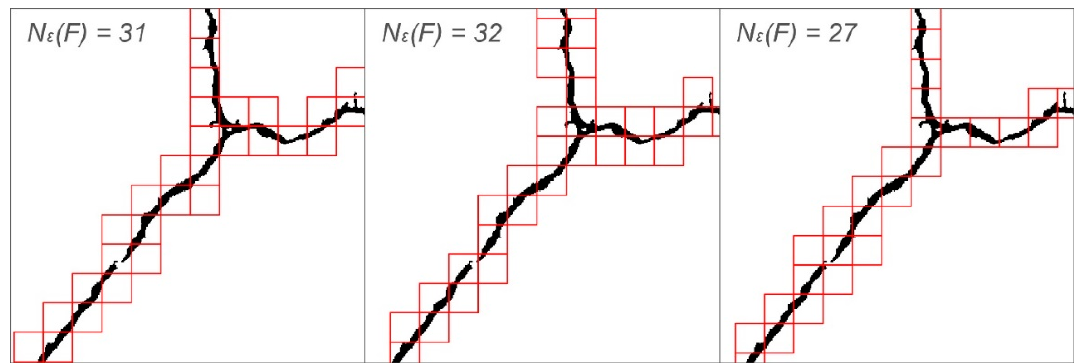
Figure 4. Number of boxes containing significant pixels at different grid orientation positions, for the same calibre of the grid.